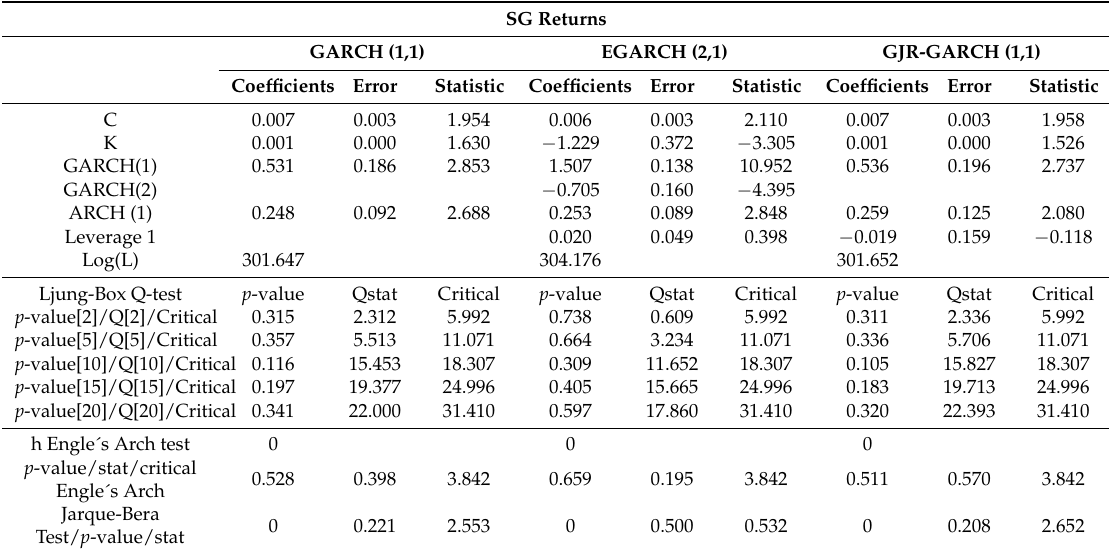
Table 2. Estimation results for different volatility